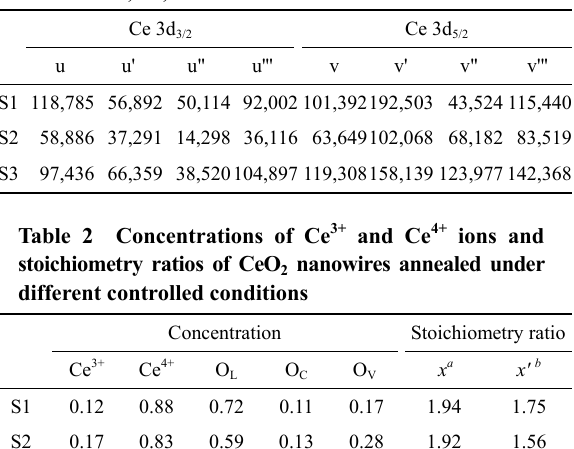
Table 1 Integrated areas of individual XPS peaks of Ce 3d in S1, S2, and S3 Ce 3d 3/2